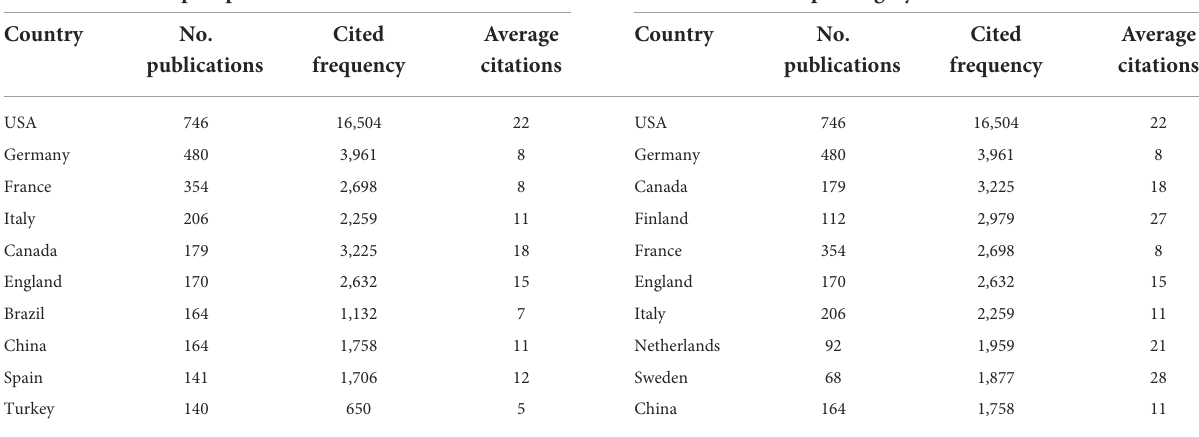
TABLE 5 Top 10 countries on occupational diseases based on